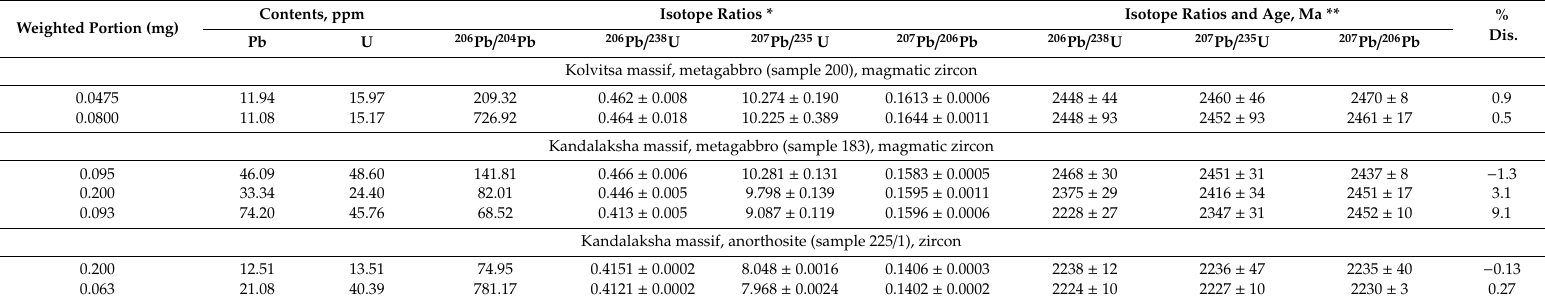
Table 3. Isotope U–Pb data on single zircon grains from metagabbro and anorthosite, Kandalaksha-Kolvitsa gabbro-anorthosite